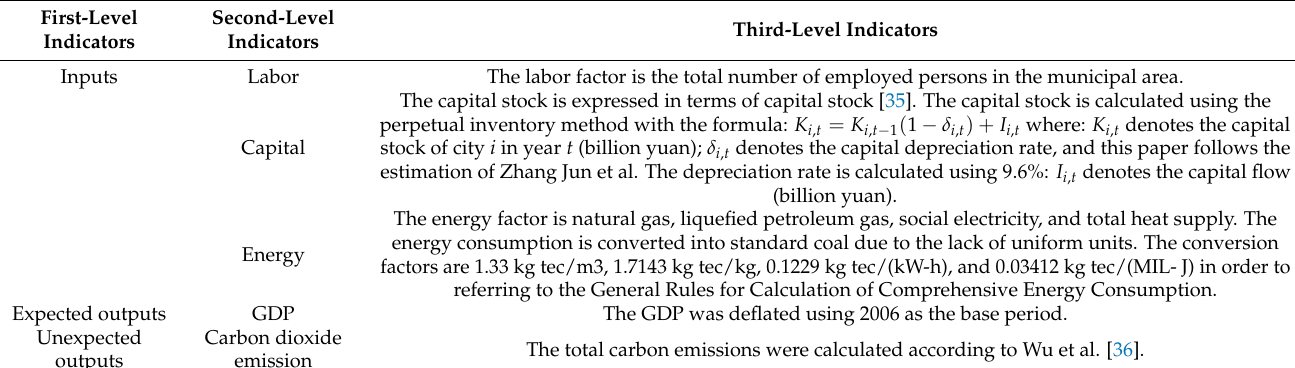
Table 1. Index system for measuring carbon emission